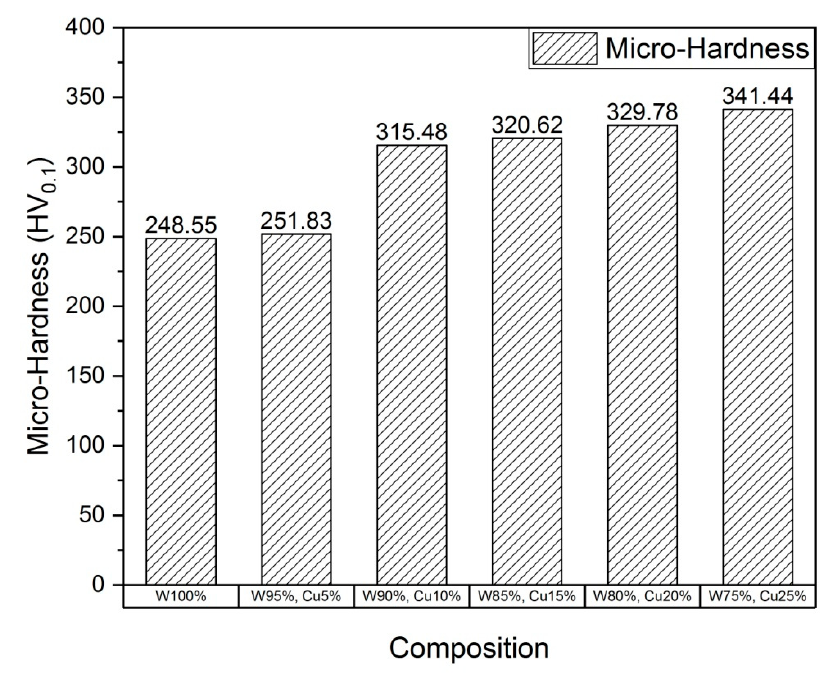
Nanomaterials 2021 , 11 , x FOR PEER REVIEW Figure 8. Plot of micro-hardness. Figure 8. Plot of micro-hardness.